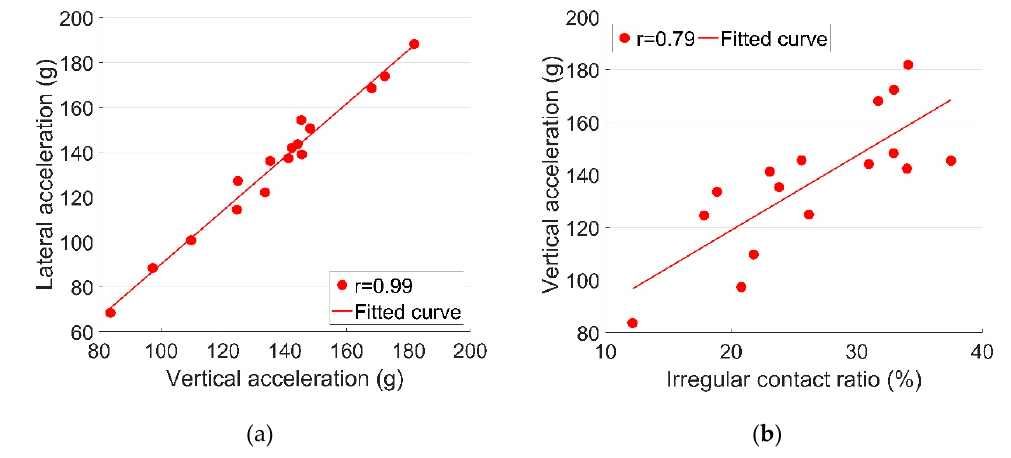
Figure 12. Correlations of the dynamic responses. ( a ) a y -a z ; ( b ) I r -a y .